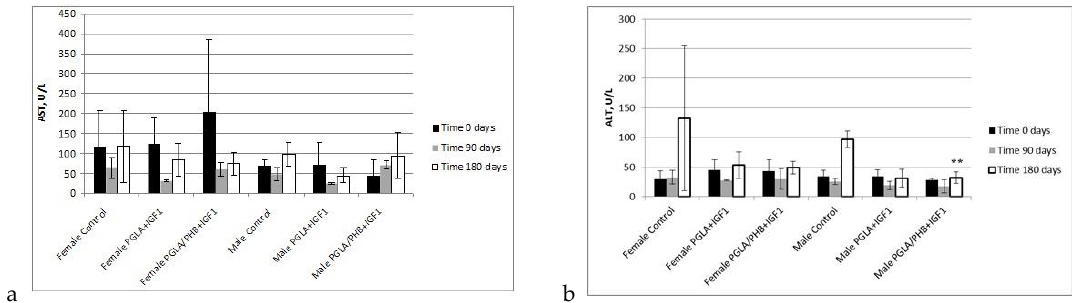
Figure 15. Aminotransferase aspartate (AST) ( a ) and aminotransferase alanine (ALT) activate ( b ) in blood of rabbits. ** statistically significant differences at p < 0.01.